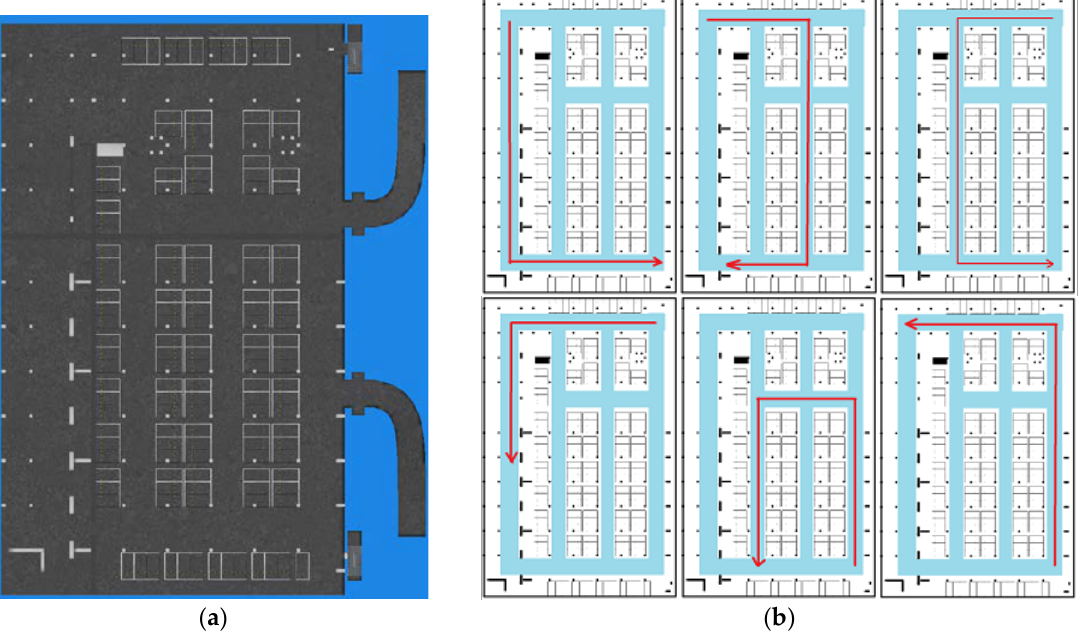
Figure 19. Experimental area plan and examples for crowdsourcing traces: ( a ) the floor plan of the underground parking; ( b ) parts of test traces collected by crowdsourcing users in our experiment.